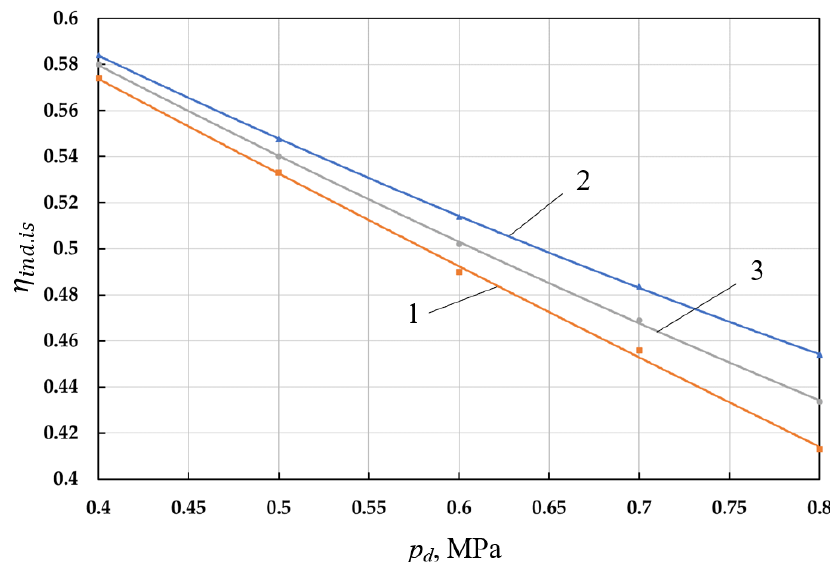
Figure 10. Dependence of the indicator isothermal efficiency of the left (1 — 𝜂 𝑖𝑛𝑑.𝑖𝑠1 ) , right (2 — 𝜂 𝑖𝑛𝑑.𝑖𝑠2 ) cylinders and their average value (3 — 𝜂 𝑖𝑛𝑑.𝑖𝑠.𝑎𝑣 ) on the discharge pressure.